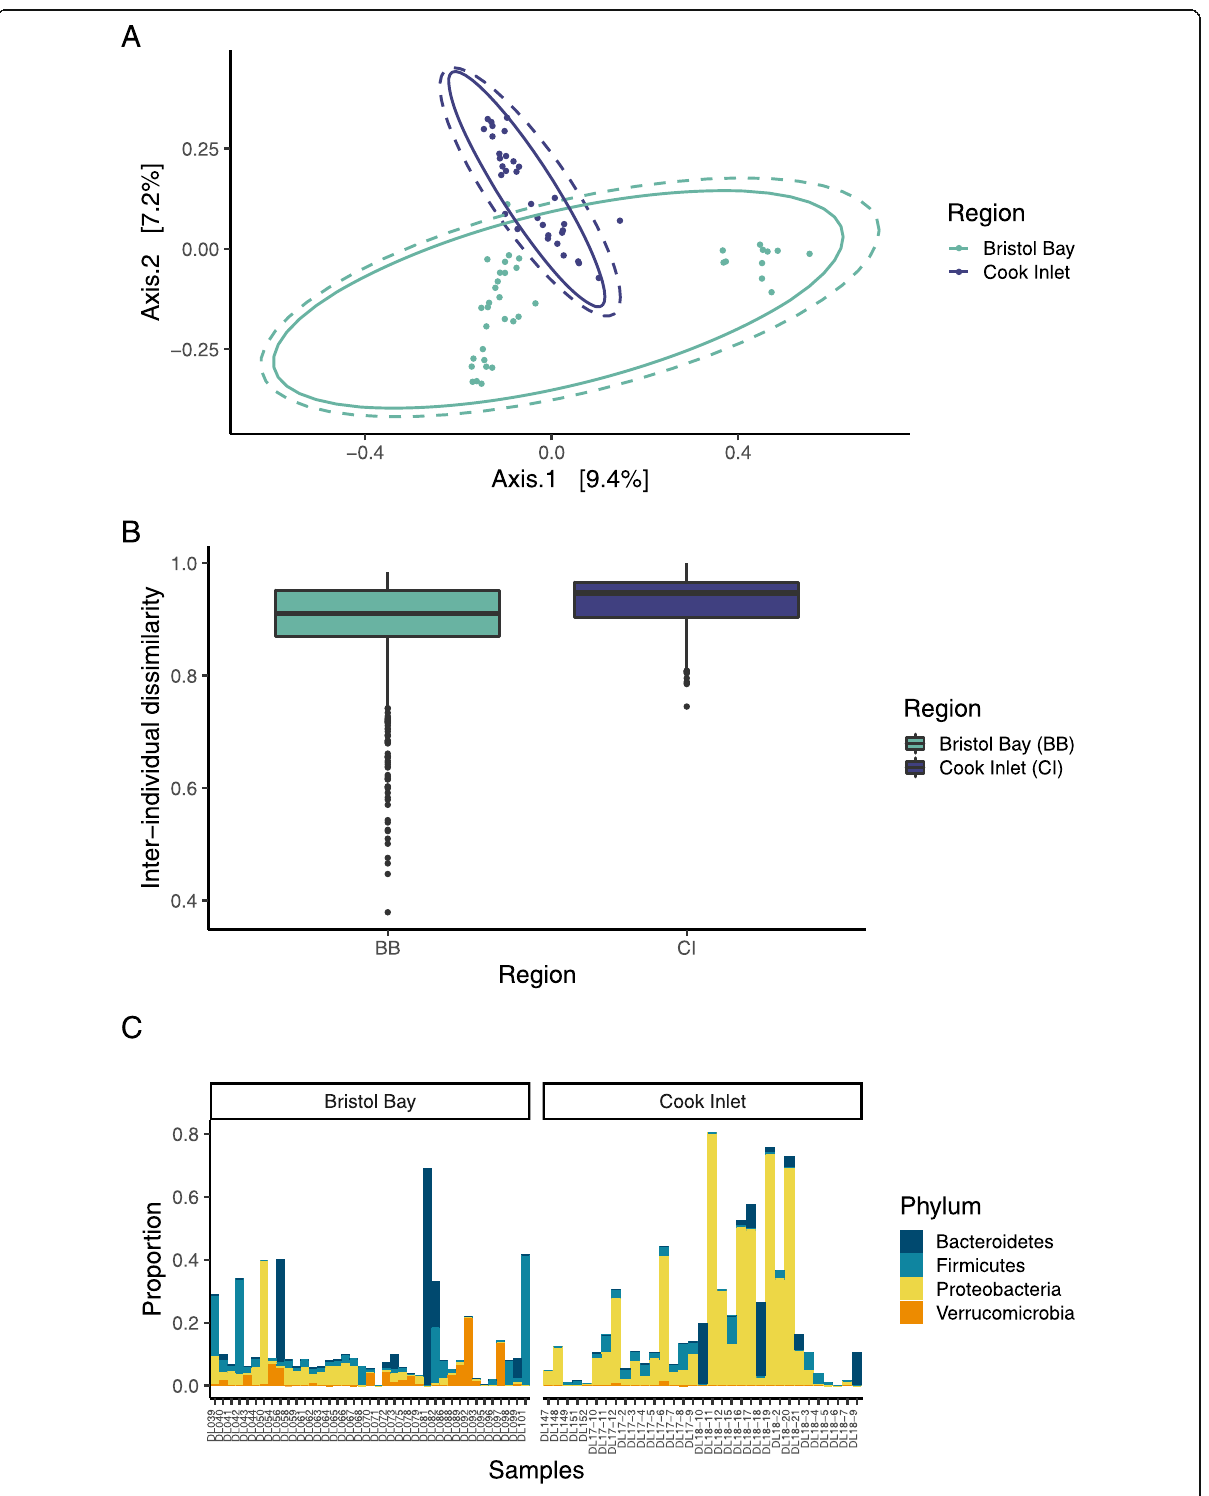
Fig. 2 Comparison of epidermal microbial communities in Bristol Bay and Cook Inlet beluga whales. a PCoA based on Bray-Curtis dissimilarity comparison of the epidermal microbiota. Multivariate normal and t-distributional data ellipses are shown in dotted and solid lines, respectively. b Beta diversity within each regional population, estimated by calculating Bray-Curtis dissimilarity between individual microbial communities within populations. c Proportional abundances of top 20 ASVs, organized by phylum, found on individual whales in Bristol Bay and Cook